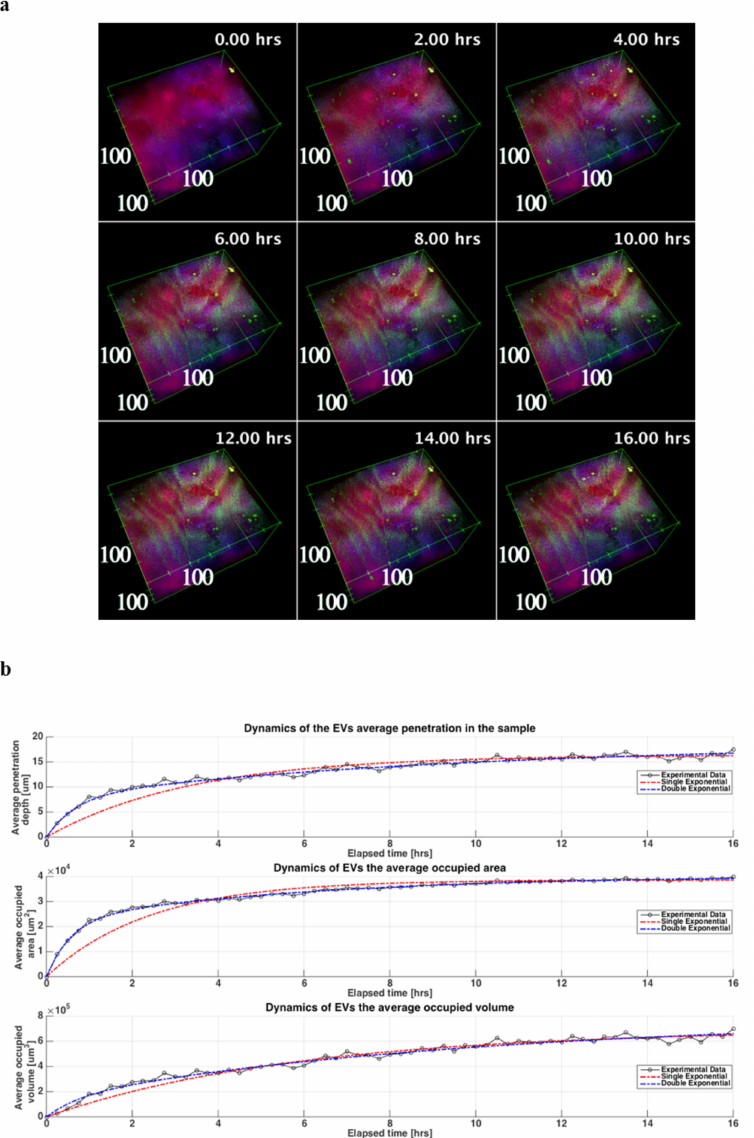
Figure 4. ASC-EVs kinetic of penetration in OA cartilage. ( a ) 3D reconstructions of the cartilage explant during the time-lapse experiment where the cells and the rich lipidic structures are shown in red (CARS signal at 2848 cm − 1 from lipid structures), the collagen rich ECM is shown in blue (SHG signal from collagen) end the EVs are shown in green (TPEF signal from EVs fluorescence stain). In the box is shown the scale in µ m, while in the upper right corner is depicted the corresponding time of the image during the experiment. The reconstructions are obtained from the acquired images and processed using 3Dviewer with ImageJ. ( b ) Three graphs of the dynamics of the EVs in the tissue during the time-lapse related to the depth, the area and the volume are showed. For each curve are also plotted the related fitting in blue the double exponential one (Equation (1) in Table S6) and in red the single exponential one (Equation (2) in Table